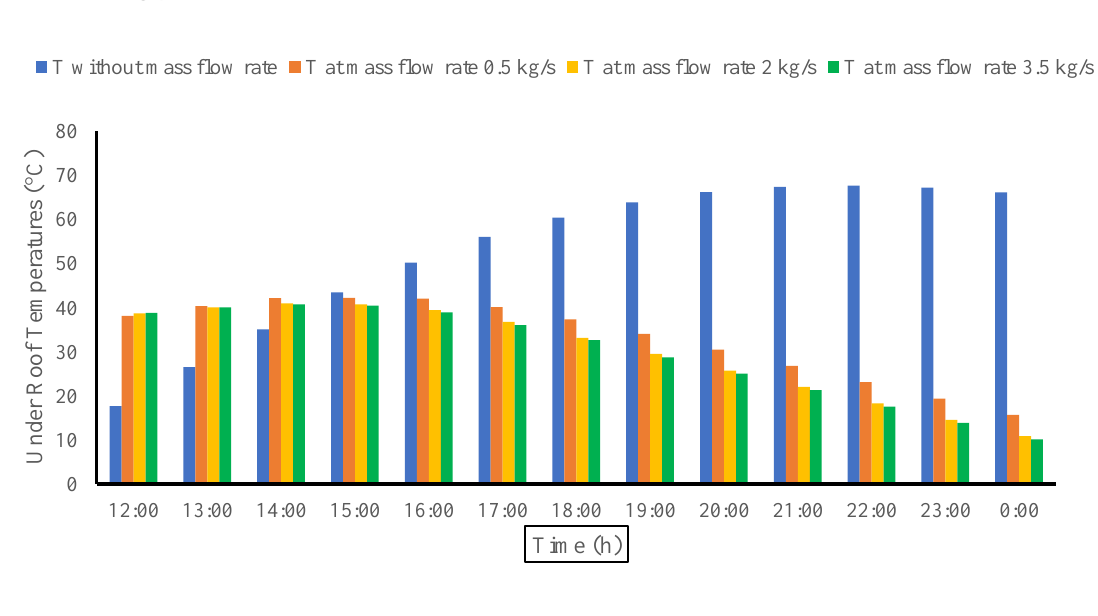
Figure 4. Under roof temperature at different times during the days with and without mass flow